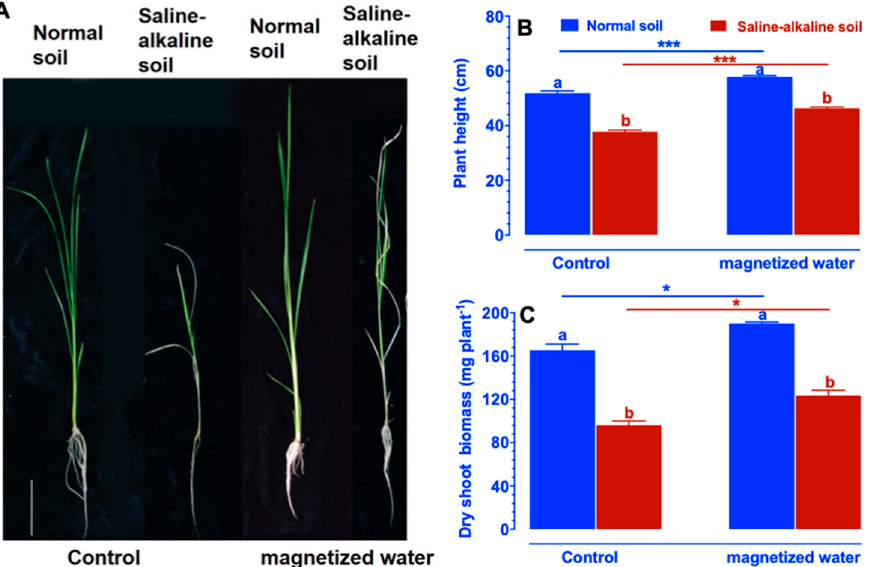
Figure 1. Effects of magnetized water on Nipponbare seedlings under saline–alkaline stress condi- tions. ( A ) Growth performance. ( B ) Plant height. ( C ) Dry shoot biomass. Two-week-old rice seedlings grown in standard culture solution were transplanted into soil containing 60 mM NaHCO 3 and a pH of 8.5. Then, for two weeks, they were irrigated with magnetic water. Irrigation water was magnetized by flowing through a 3000 gauss magnetron device with a 0.5-inch diameter magnetic field. Bars = 10 cm. Daare means ± SE ( n ≥ 4). Means with different letters are significantly different ( p < 0.05) within the same treatment. Asterisks indicate significant differences between control and saline–alkaline stress of the same genotype, as determined by Student’s t -test (* p < 0.05, *** p < 0.001).